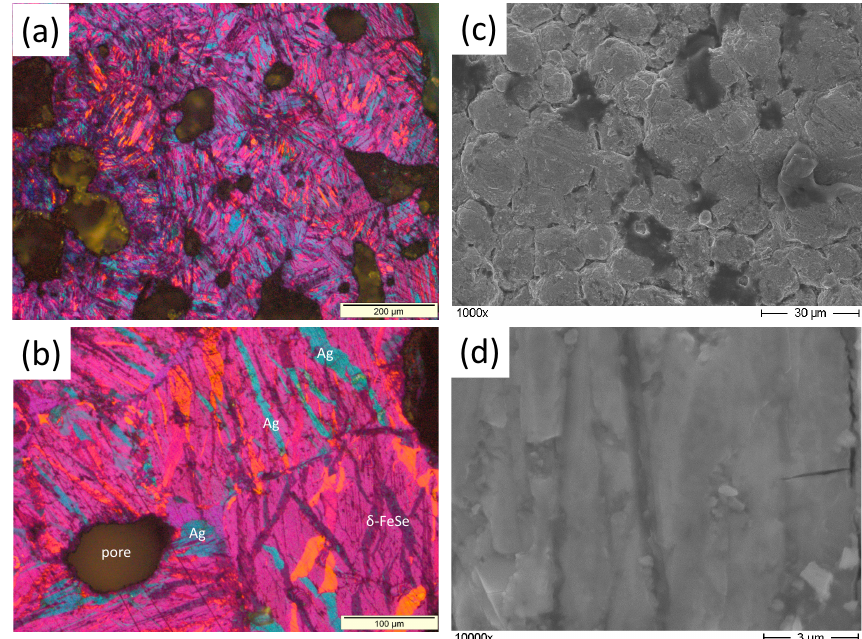
Figure 1. ( a , b ) Polarization images of the 4%-FeSe+Ag-sample. ( c , d ) SEM images of the same sample. The polarization images directly reveal the various phases and give an impression of the porosity. The metallic Ag particles appear in light blue color; the remaining δ -FeSe phase is imaged in dark grey; and the different orientations of the superconducting β -phase are in reddish colors. Note also the typical acicular shape of the δ -FeSe grains. The α -Fe and Fe 7 Se 8 particles are too small to be seen in the optical